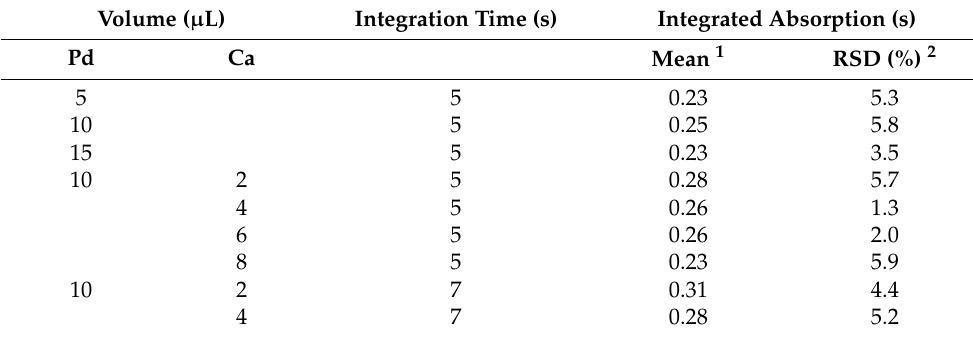
Table 2. Determination of the volume of palladium (10 g L − 1 ) and calcium (1 g L − 1 ) within the gen- eration of the diatomic molecule CS.